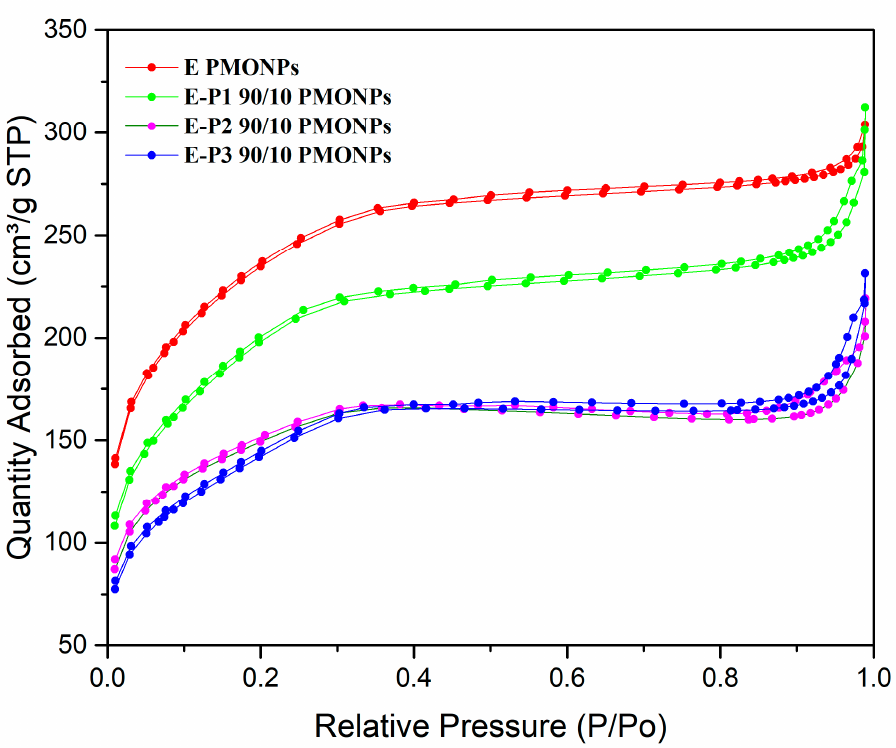
Figure 2. N 2 adsorption ‐ desorption experiments (BET) of E , E ‐ P1 , E ‐ P2 , E ‐ P3 , at a proportion of